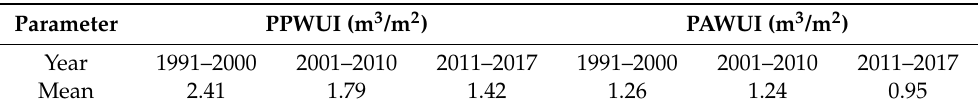
Table 7. Comparison of different categories of mosques based on year built showing the pre- and post-audit water use intensity mean values.